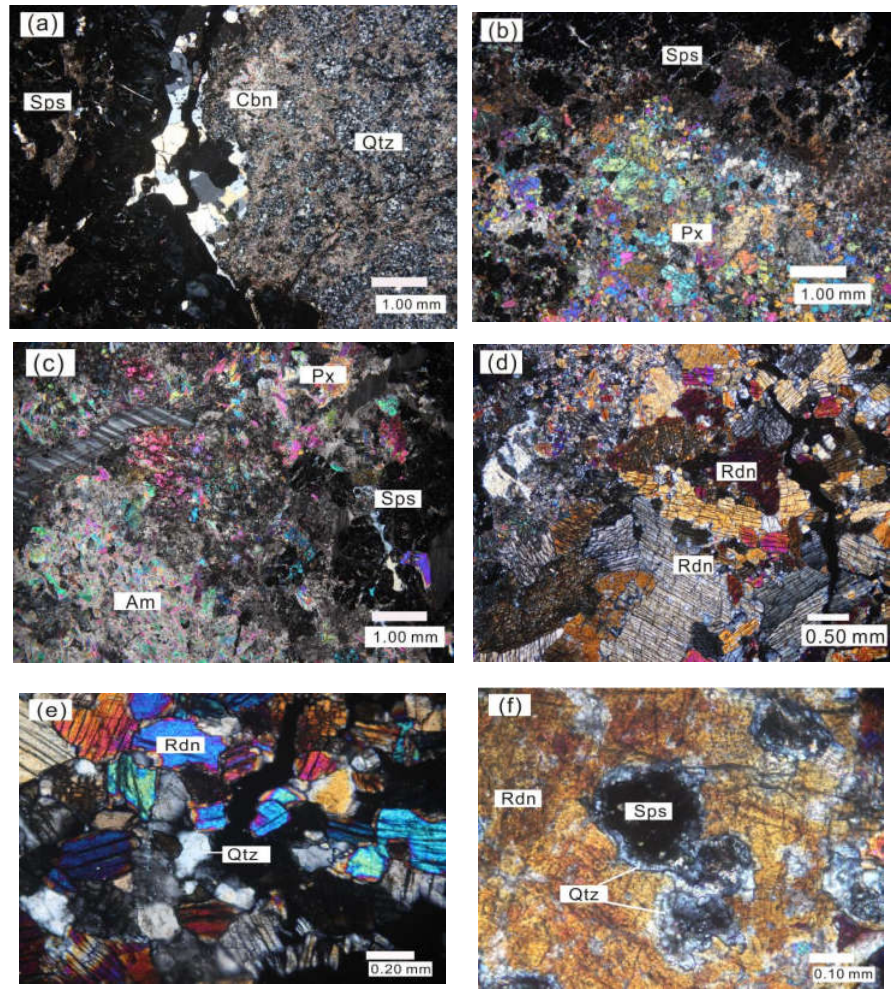
Figure 3. Characteristics of JingFenCui under polarizing microscope (crossed-polarized light): ( a ) carbonate (Cbn), quartz (Qtz), and spessartine (Sps); ( b ) spessartine and pyroxene (Px) at the junction of Zone B and Zone C; ( c ) amphibole (Am) of fiber-columnar and sheet structure in Zone C; ( d ) parallel and near-rectangular cleavage of rhodonite; ( e ) inclusions of quartz, carbonates, and spessartine are present in rhodonite (Rdn); ( f ) quartz-rimmed spessartine encased in